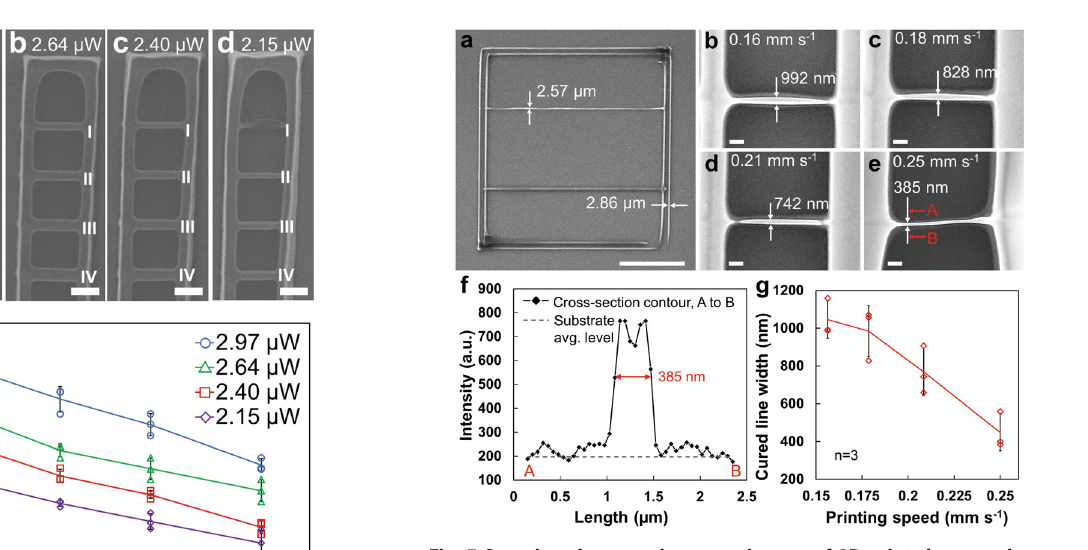
Fig. 5 Scanning electron microscope images of 3D printed nanoscale structures. a 300 × 300 µ m square printed with microscale lines with a width of approximately 3 µ m (scale bar represents 100 µ m). The nanoscale structures were cured at printing speeds of b 0.16, c 0.18, d 0.21, and e 0.25 mm s − 1 , resulting in line widths of 992, 879, 769, and 385 nm, respectively. Two vertical lines (width approximately 5 µ m) were printed with a distance of 15 µ m to suspend the nanometre structures (scale bars represent 2 µ m). f Cross-section contour of 385-nm-width structure in e . g Cured nanoscale width according to printing speed at a laser power of 2.40 µ W and a photopolymer thickness of 6 µ m ( n represents sample size, while error bars represent one standard